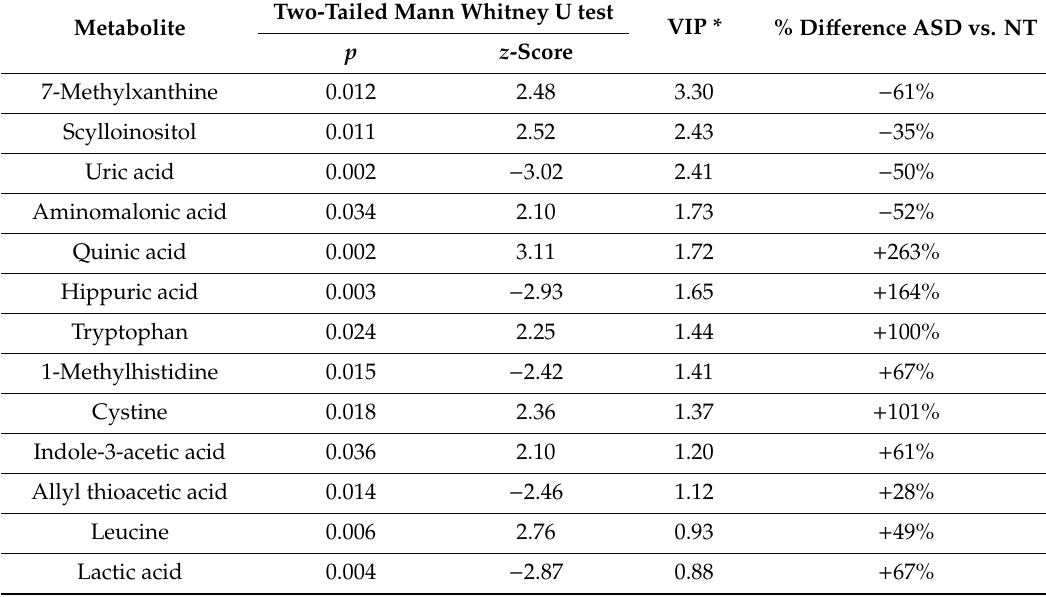
Table 3. List of the most significant metabolites, obtained by univariate and multivariate statistical analysis, discriminating children with autism spectrum disorder (ASD) from neurotypical (NT) children. Two-Tailed Mann Whitney U test VIP Metabolite